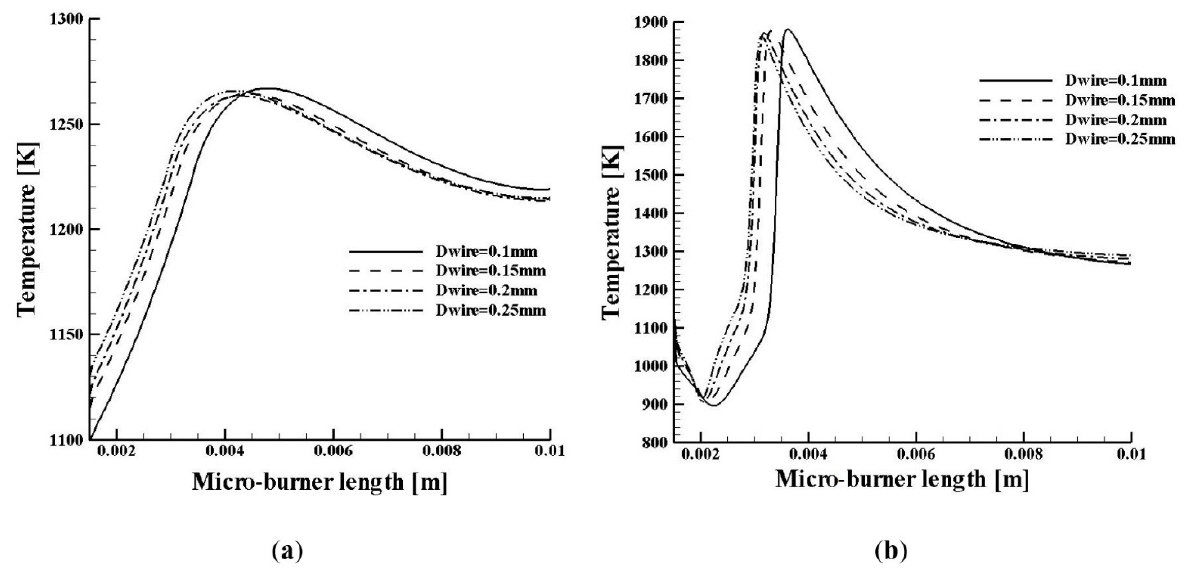
Figure 7. ( a ) Distribution of temperature on the outer surface of the micro-burner for different diameters of the inserted wire; ( b ) distribution of temperature on the axial line defined at r = 0.3 mm for different diameters of the inserted wire.